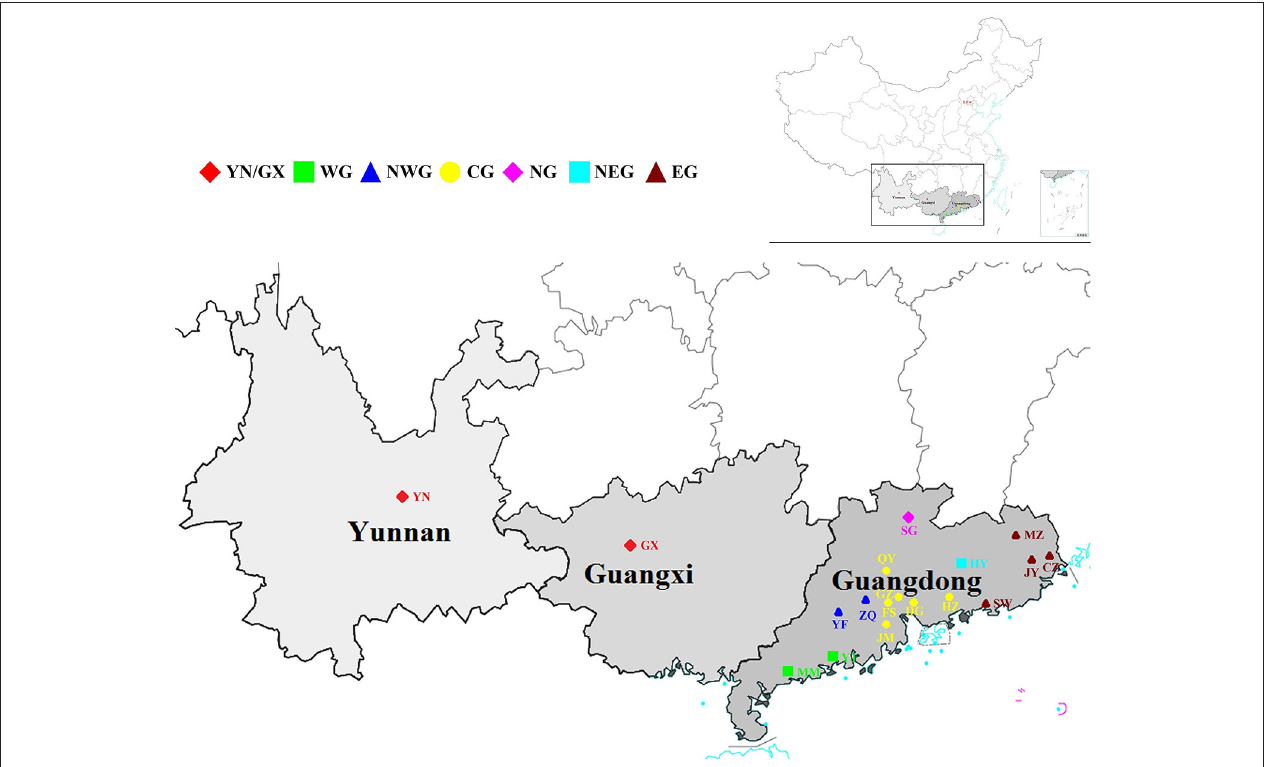
FIGURE 1 | Geographical distribution of the collected Schima superba accessions. All the accessions were collected from 18 geographical sites and can be summarized into seven subpopulations according to the environment. The subpopulations were marked with seven different colors. The map was obtained from the official website of the Ministry of Natural Resources of China (http://bzdt.ch.mnr.gov.cn/index.html)